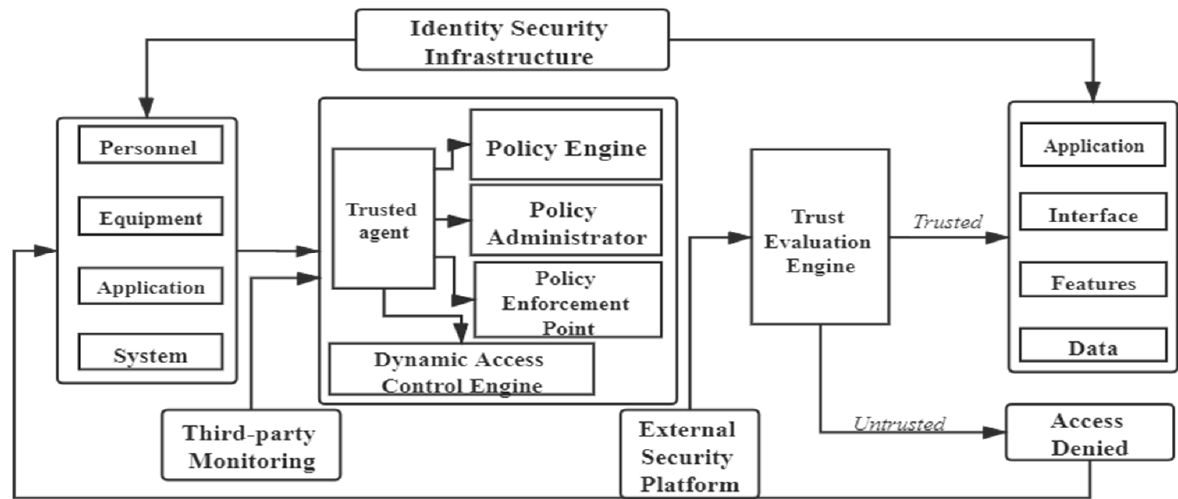
Figure 1. Zero-trust security model architecture components.